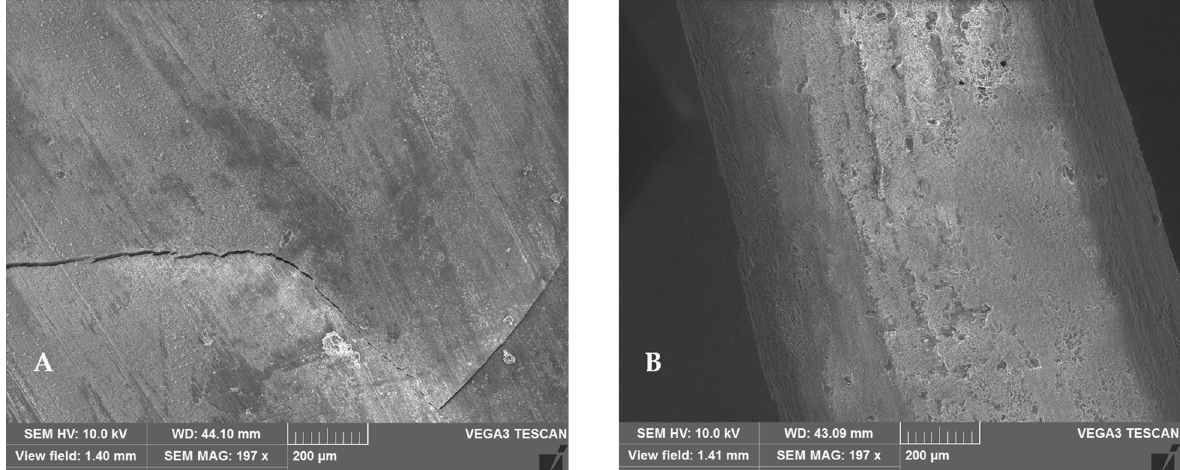
Figure 11. Scanning-electron-microscope image of ( A ) Sectioned root canal, and ( B ) displaced post, at 200× magnification, showing cohesive failure mode in Group 3 (CPTPCs) sample at root/post interface.